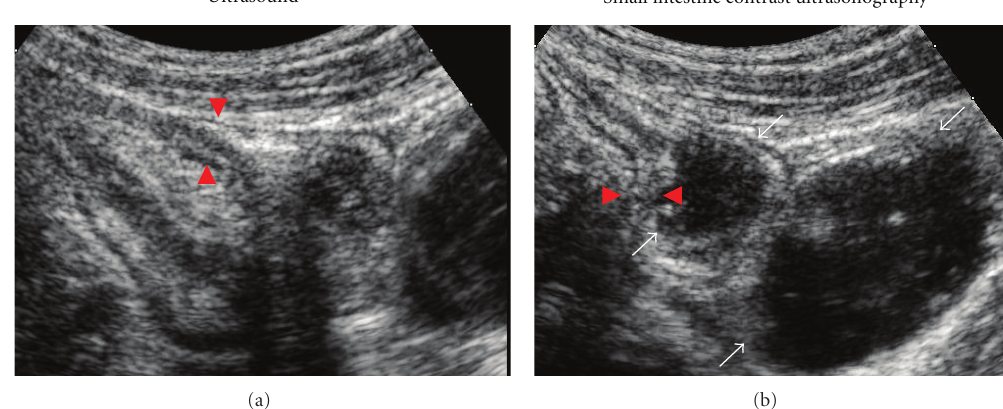
Figure 2: A 30-year-old male with stricturing Crohn’s disease assessed by bowel ultrasound (without oral contrast) (a) and small intestine contrast ultrasonography (b). (a) shows Crohn’s disease stenosis and prestenotic dilation, well defined in (b). Red arrowheads indicate bowel wall thickness in both panels, white arrows indicate prestenotic dilation in (b).